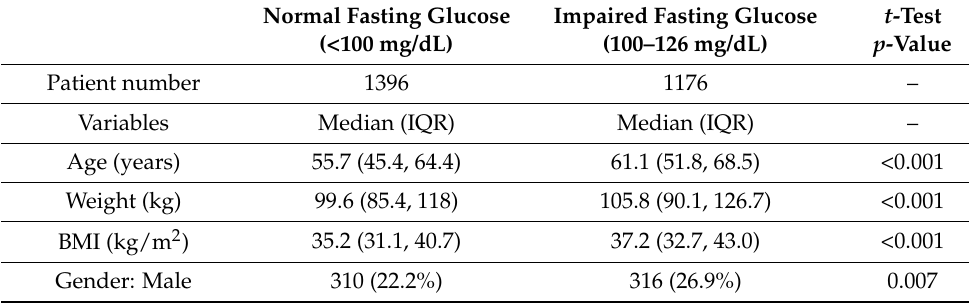
Table 1. Demographic